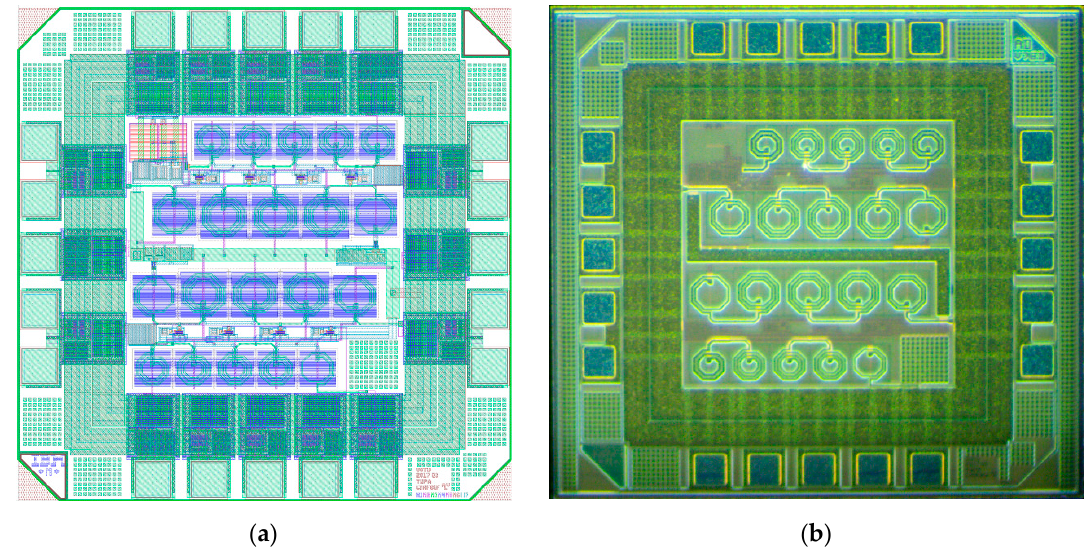
Figure 3. IBM 0.13 μ m CMOS traveling-wave amplifier: ( a ) layout, ( b ) fabricated IC. Figure 3. IBM 0.13 µ m CMOS traveling-wave amplifier: ( a ) layout, ( b ) fabricated